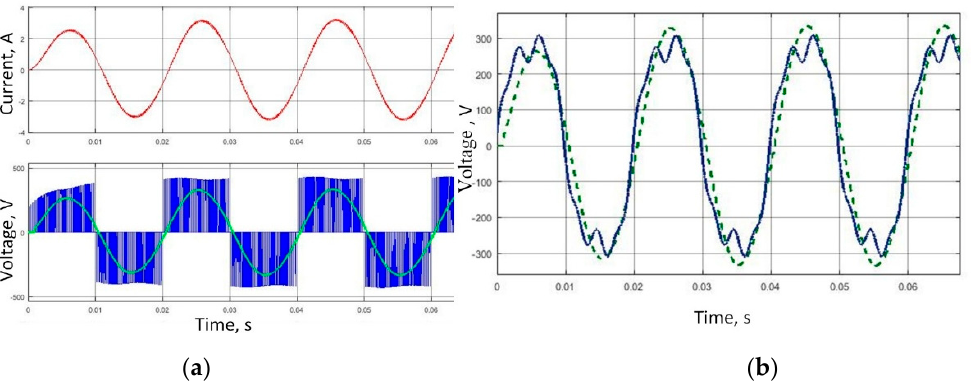
Figure 5. Modeling of the circuit with a single-phase SST: ( a ) SST-load current and voltage (green line is the average voltage); ( b ) Comparison of input and average output voltage in the SST.